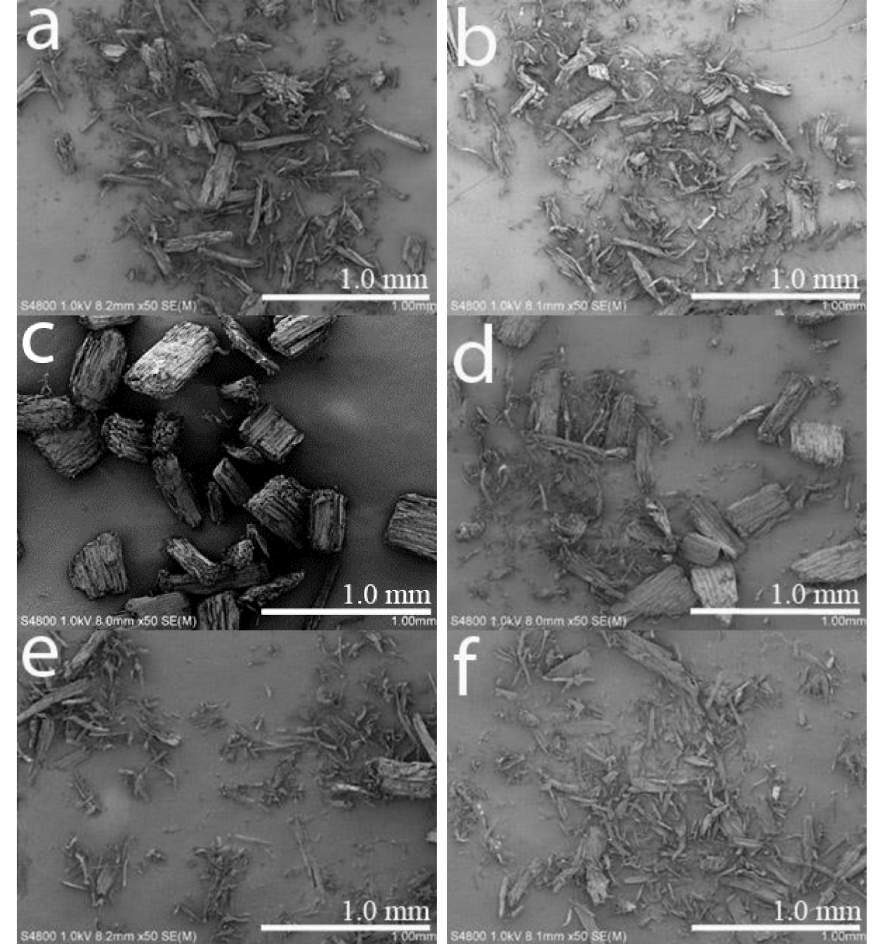
Figure 2. Scanning electron microscopic images of ( a ) CWF S 00, ( b ) CWF S 200w, ( c ) CWF L 00, ( d ) CWF L 200w, (e) PWF00, and (f)